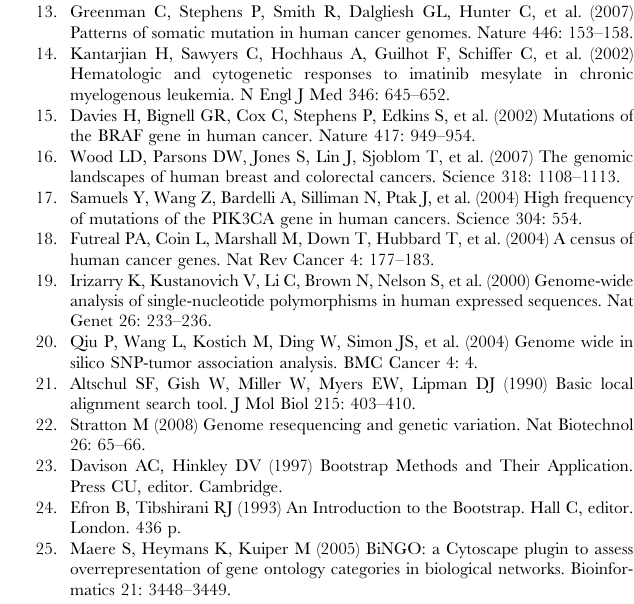
Table S2 Functional (Gene ontology, biological process) chart of the candidate cancer recessive genes, FDR ,